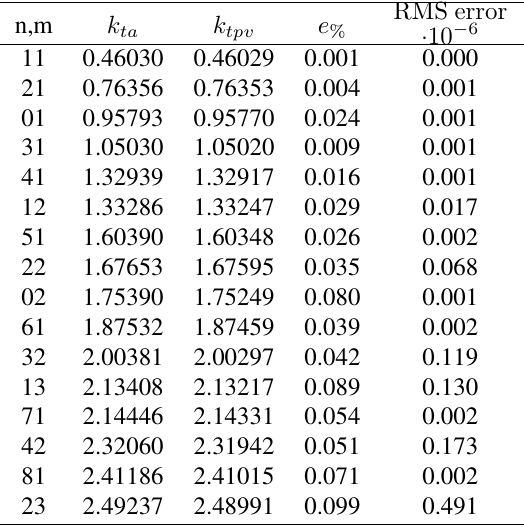
Table 2: Validation test for a circular